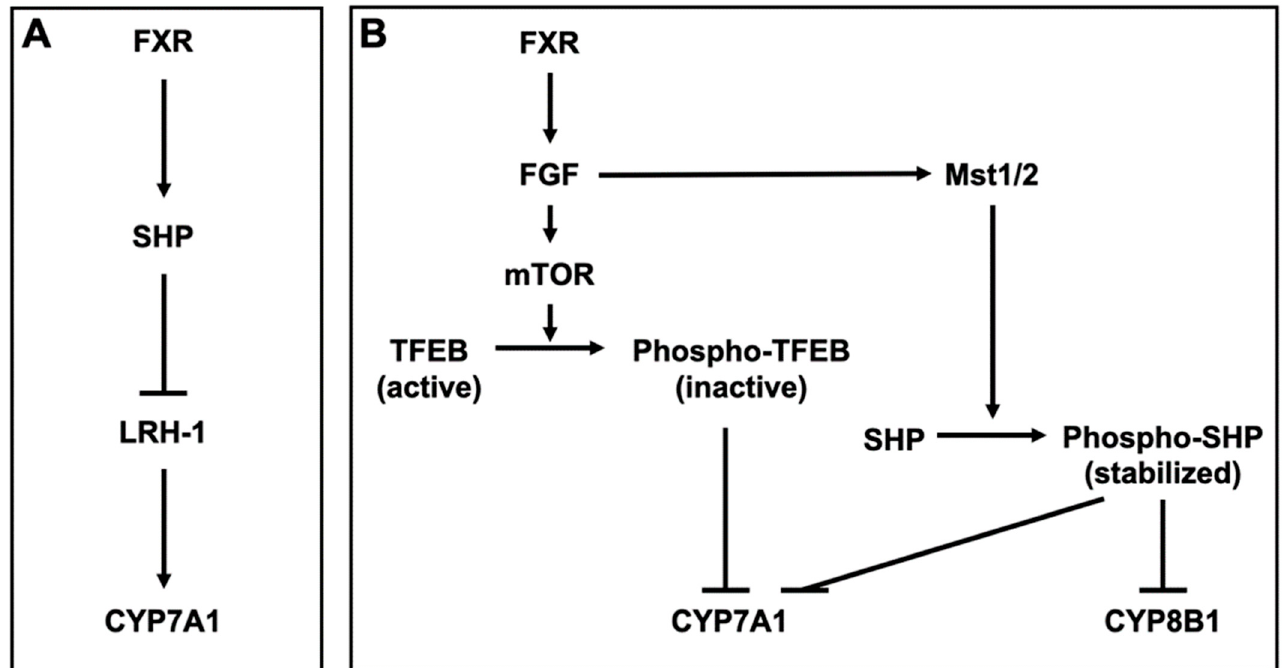
Figure 2. Bile acid metabolism by FXR ( A ) Farnesoid X receptor (FXR) induces small heterodimer partner (SHP) and SHP inhibits liver receptor homolog-1 (LRH-1), which induces cytochrome P450 (CYP) 7A1 in the hepatocyte. ( B ) FXR induces fibroblast growth factor (FGF) 15/19 (mouse FGF15 and human FGF19) and FGF15/19 in the enterocytes. In the hepatocyte, FGF15/19 activates FGF receptor 4 (FGFR4) and its coreceptor β -Klotho ( β KL), leading to the phosphorylation of transcription factor EB (TFEB) by the mechanistic target of rapamycin (mTOR). TFEB induces CYP7A1 and is